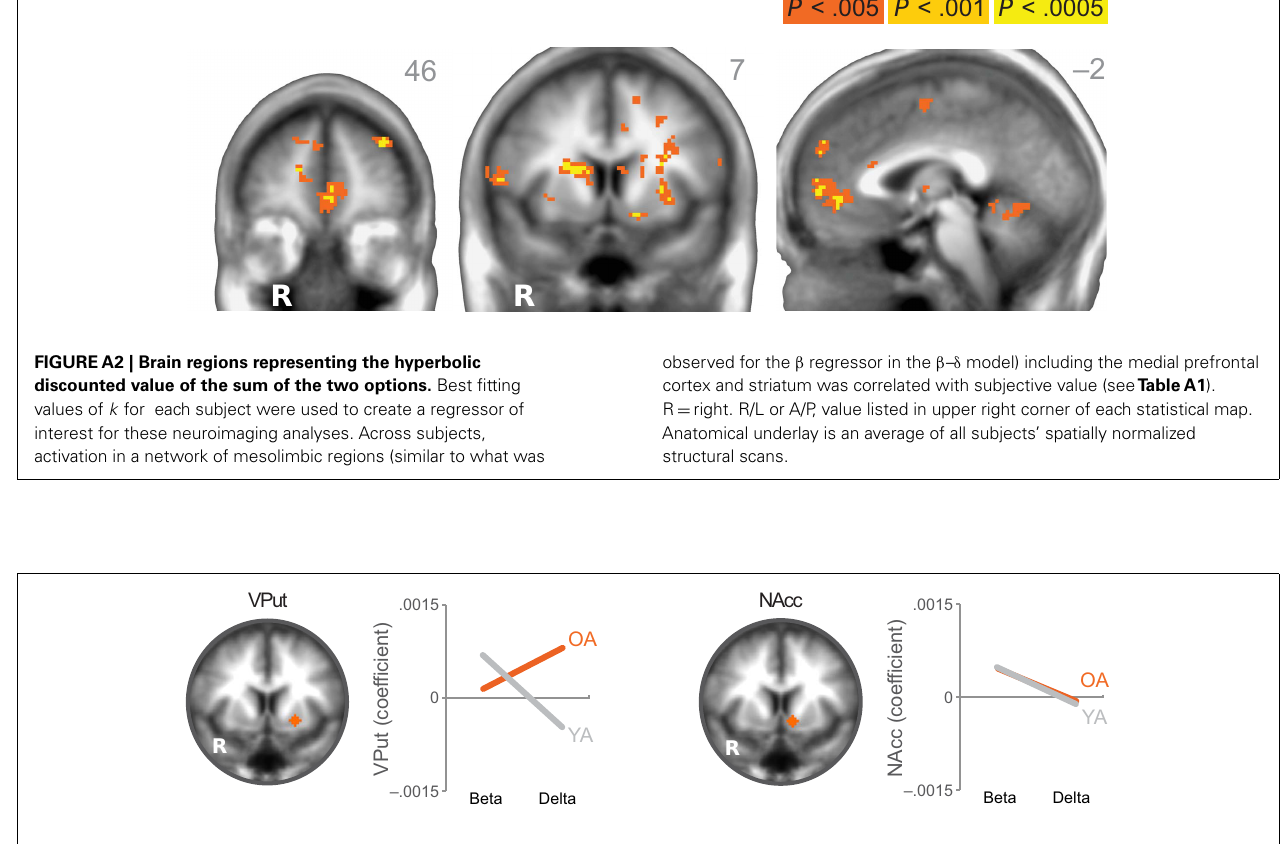
FIGUREA3 | Regression coefficients for β and δ effects were extracted from regions of interest in the ventral putamen and nucleus accumbens. As reported in the main text, older adults (OA) and younger adults (YA) showed significantly different δ but not β effects in the ventral putamen, but